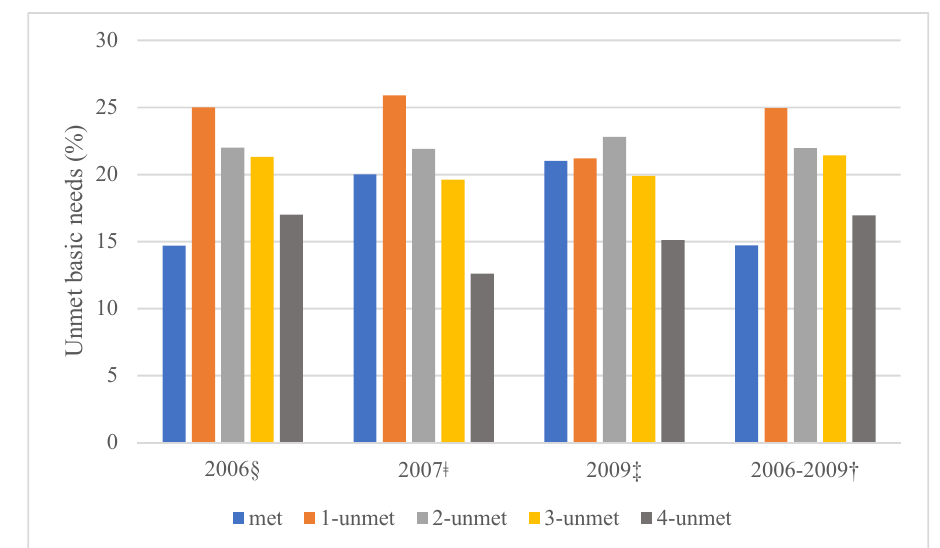
Figure 1. Distributions of unmet basic needs in people living with HIV at each time point (2006, 2007, 2009) and over time (2006–2009) in Positive Spaces, Healthy Places. § p = 0.001; ǂ p = 0.0001; ‡ p = 0.106; † p = 0.133.